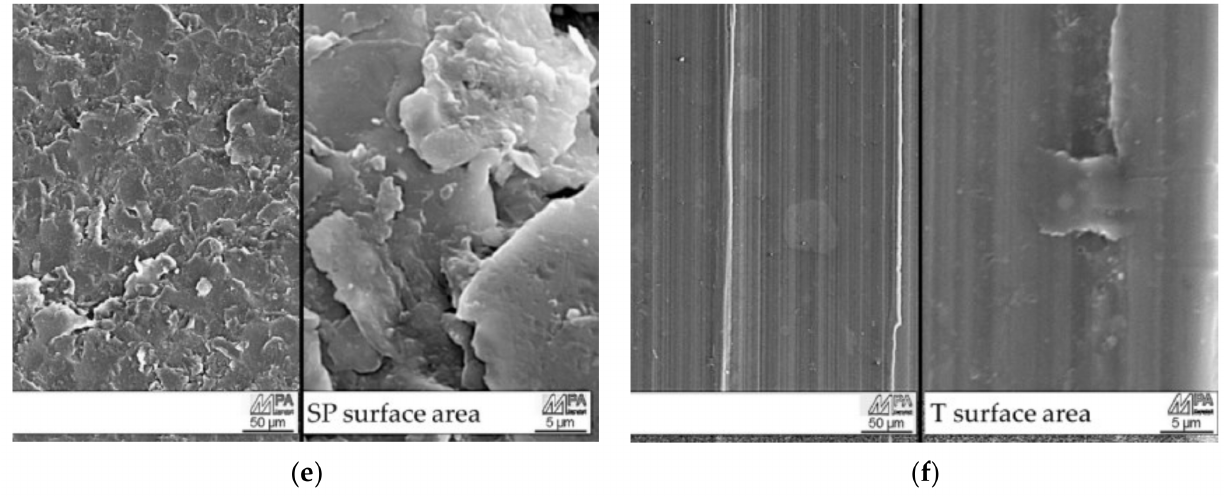
Figure 10. Exemplary SEM-images of the surfaces before the fatigue test of ( a ) as-built (AB), contour parameter sets ( b ) A, ( c ) B, ( d ) C, post process improvements, ( e ) shot peened (SP), and ( f ) turned (T)